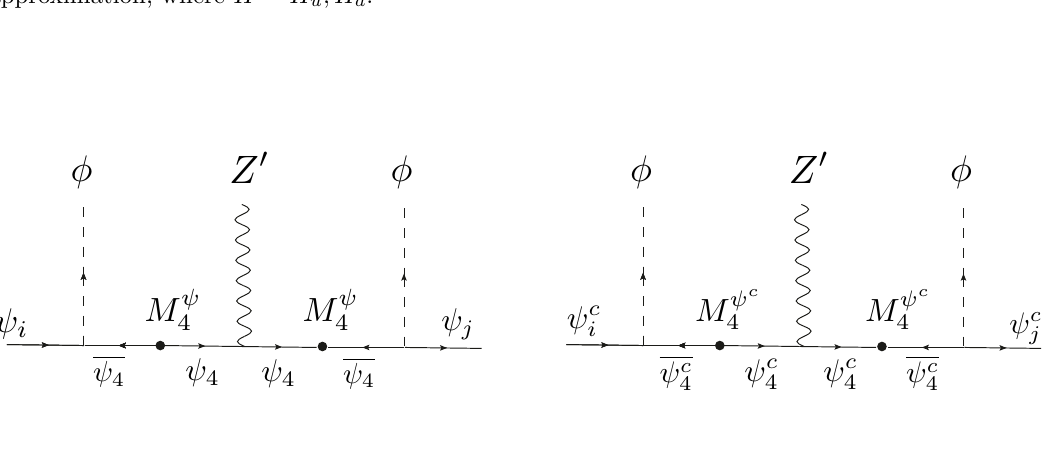
Figure 1 . Diagrams in the model which lead to the e(cid:11)ective Yukawa couplings in the mass insertion approximation, where H = H . u ; H d